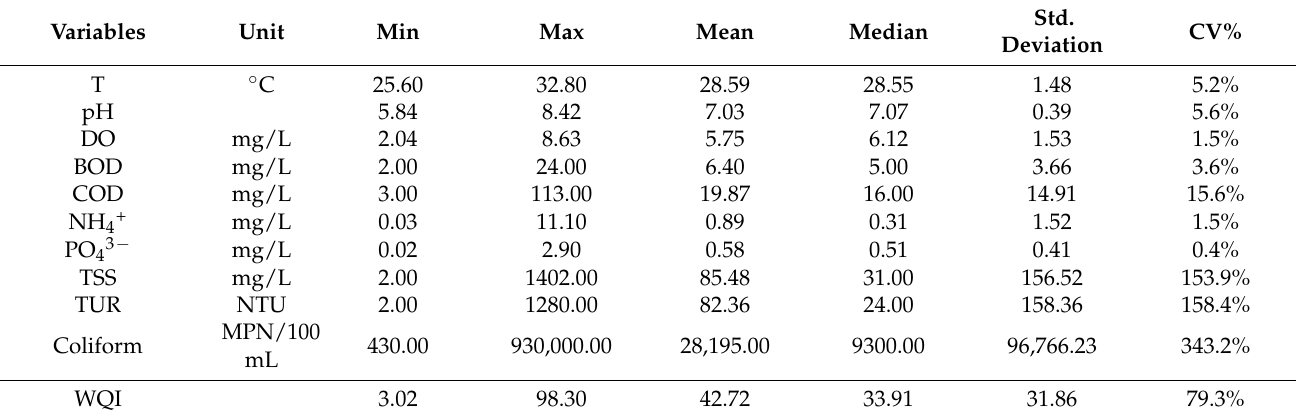
Table 1. Descriptive statistics of the observed WQ variables and WQI in the La Buong River